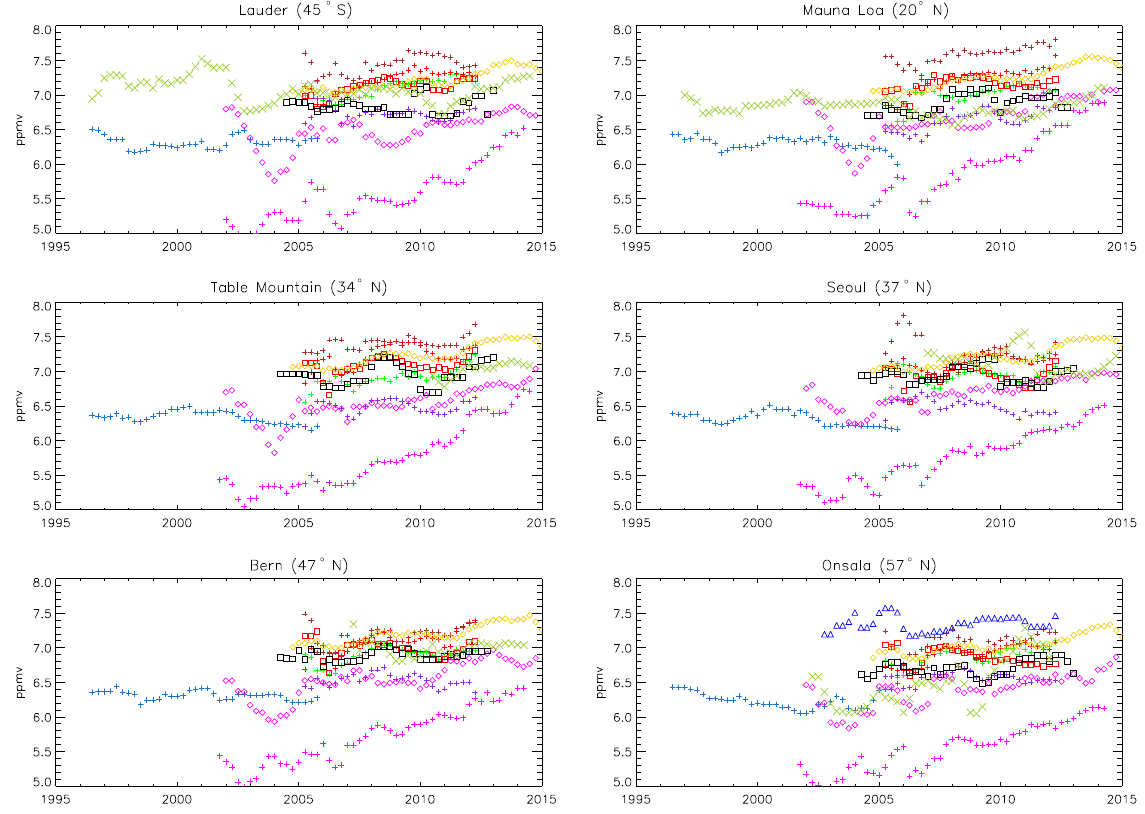
Figure 7. Measurements since 1996 at 0.46hPa from or coincident with six NDACC sites. The results shown are the annual anomaly plus the constant term from the five-parameter fit (see text). Values are shown four times per year. Symbols and colors are from Fig.